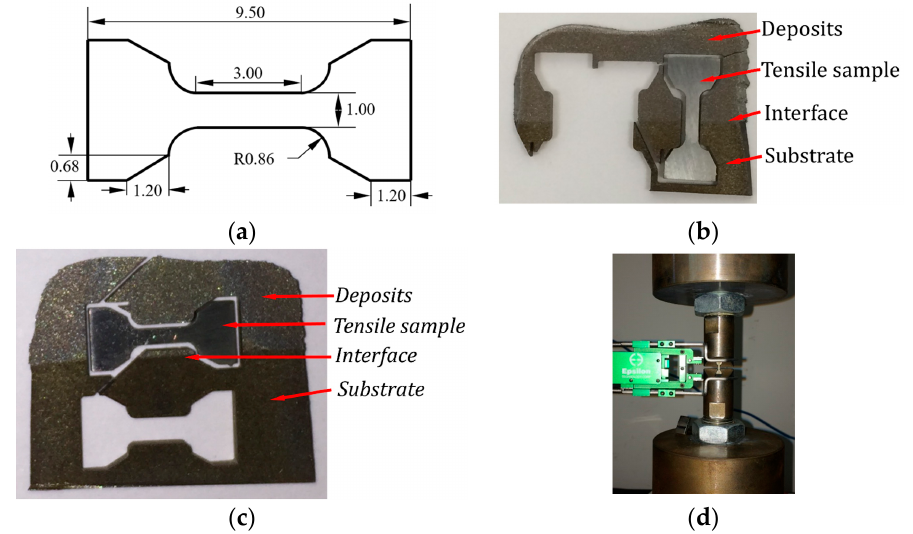
Figure 17. ( a ) Dimensions of tensile specimen (all dimensions in mm, 1 mm in thickness); ( b ) obtained Wallex 40 + H13 tool steel specimen over the sectioned part; ( c ) obtained Wallex 40 specimen over the sectioned part; ( d ) tensile testing setup.